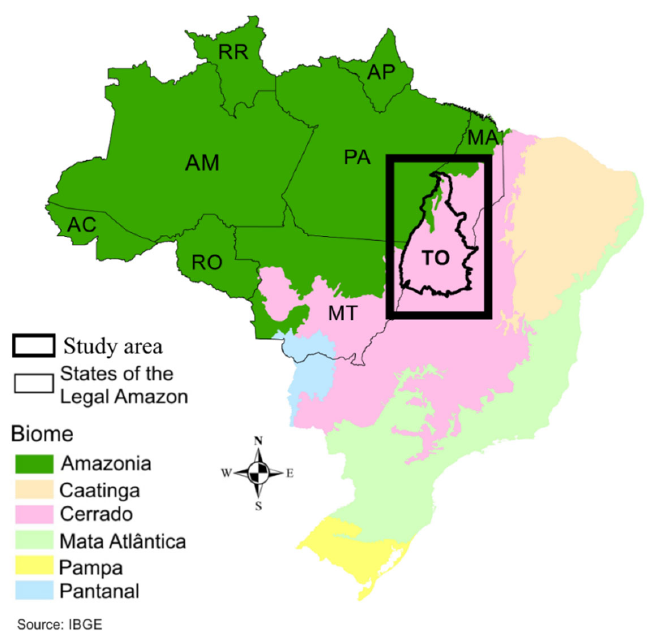
Figure 1. Location of the study area. This map was built using the software ArcGIS. AC: Acre, AM: Amazônia, AP: Amapá, MA: Maranhão, MT: Mato Grosso, PA: Pará, RR: Roraima, RO: Rondônia, TO: Tocantins.